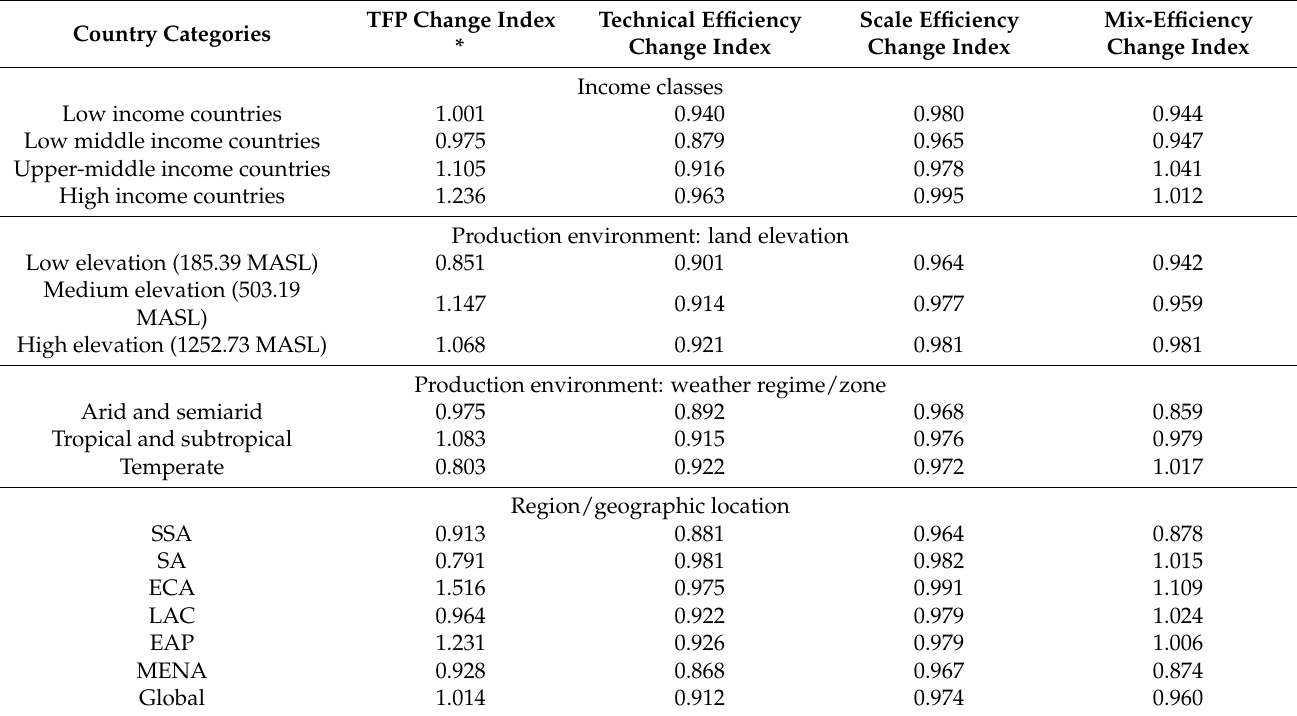
Table 3. Geometric mean of TFP change and its components for different